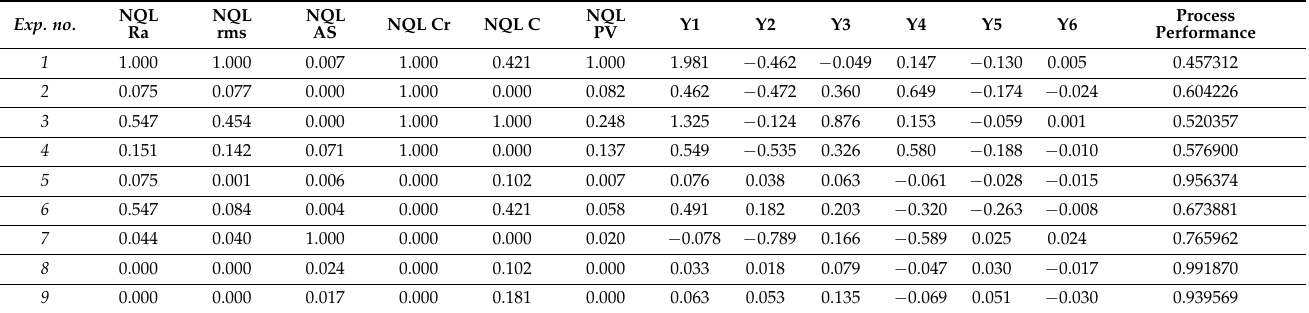
Table 5. Normalized quality loss (NQL) values, principal components scores, and process perfor- mance for argon-rich atmosphere.